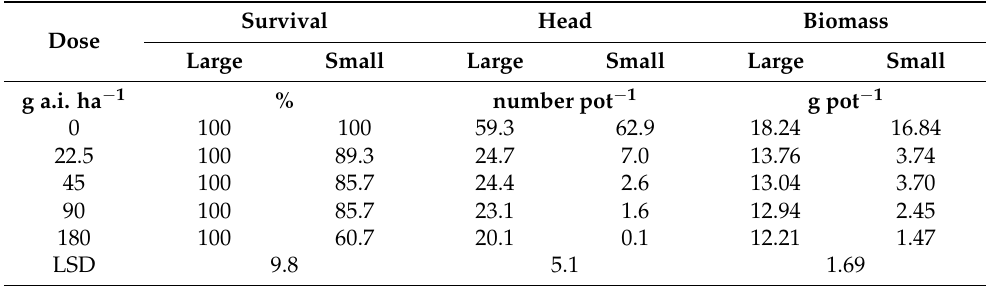
Table 4. The interaction effect of the growth stage (small, 10–12 cm in height and 14–18 leaf stage; and large, 28–30 cm in height and 60–70 leaf stage) of Navua sedge and florpyrauxifen-benzyl dose on the survival, head number, and biomass of the